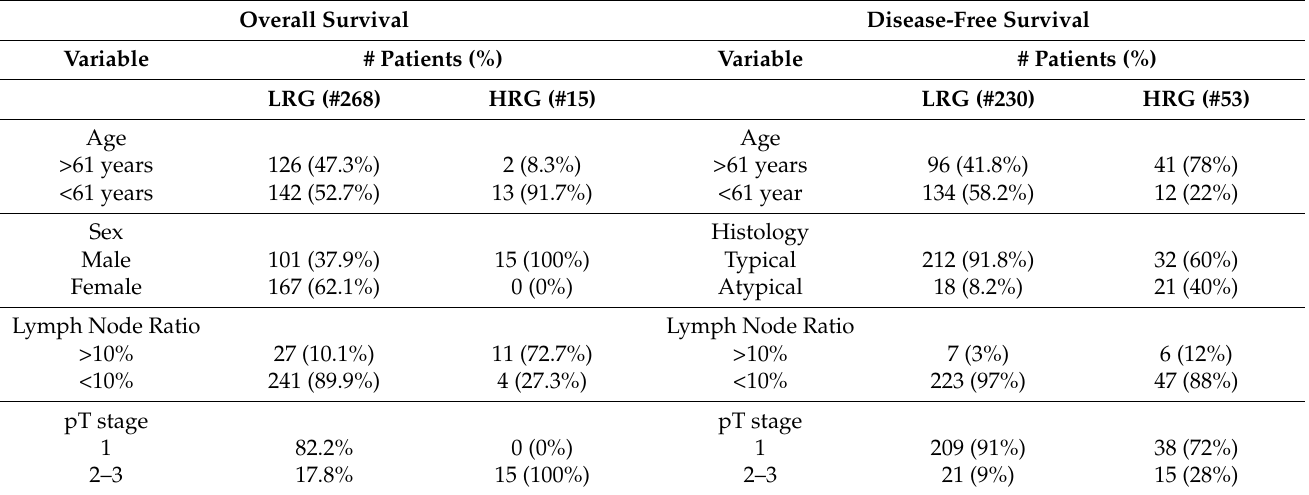
Table 3. Patient numbers according to risk categories: LRG: low risk group; HRG: high risk group.